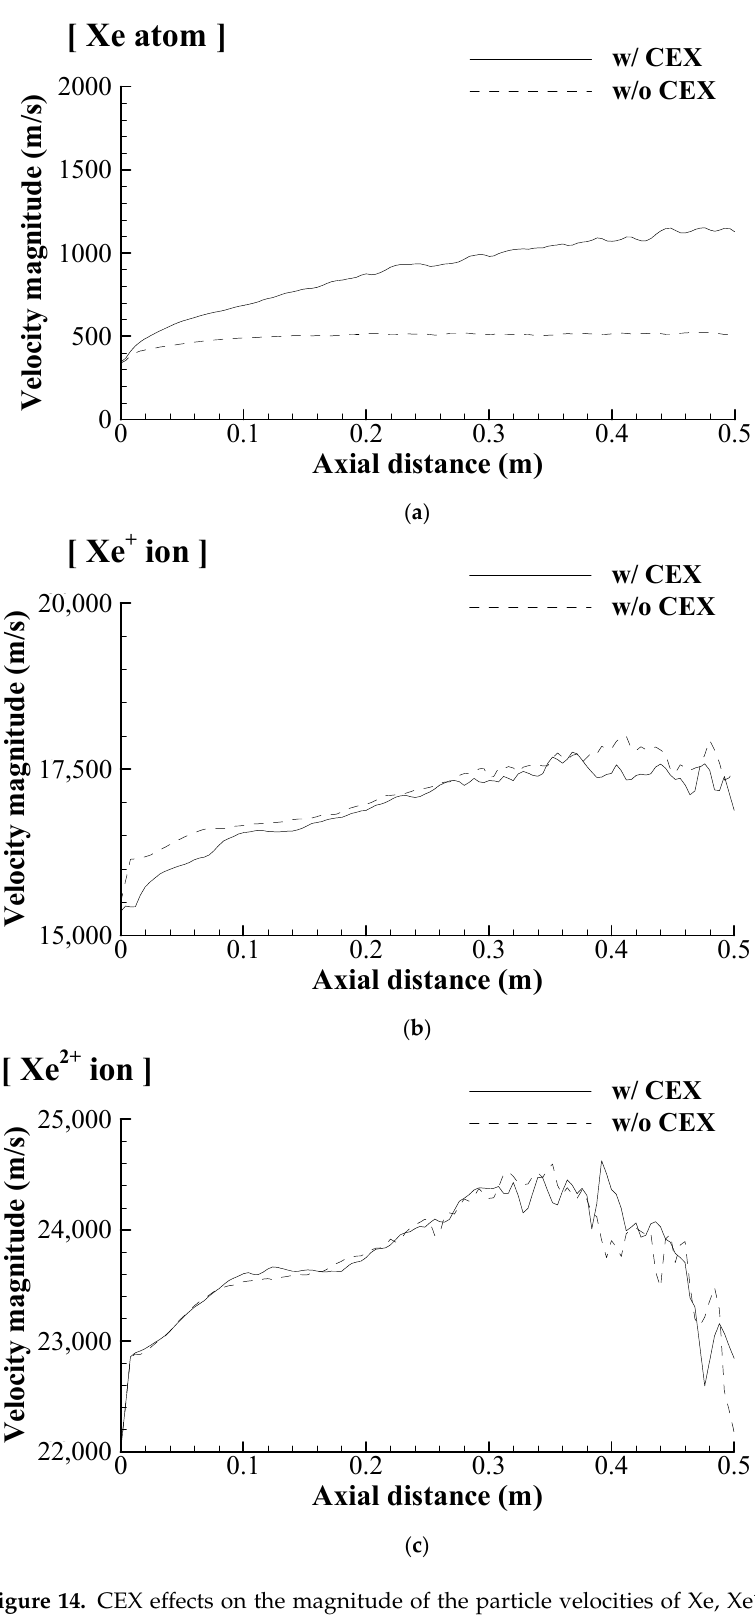
Figure 14. CEX effects on the magnitude of the particle velocities of Xe, Xe + and Xe 2+ along the thruster channel center: ( a ) Magnitude of the velocity of Xe atoms; ( b ) Magnitude of the velocity of Xe + ions; ( c ) Magnitude of the velocity of Xe 2+